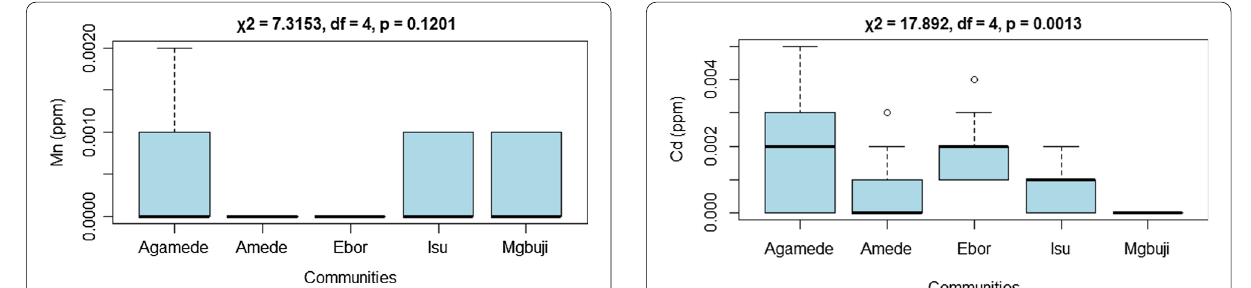
Fig. 7 Comparison of bioaccumulation of Cd in Achatina spp amongst sampled communities